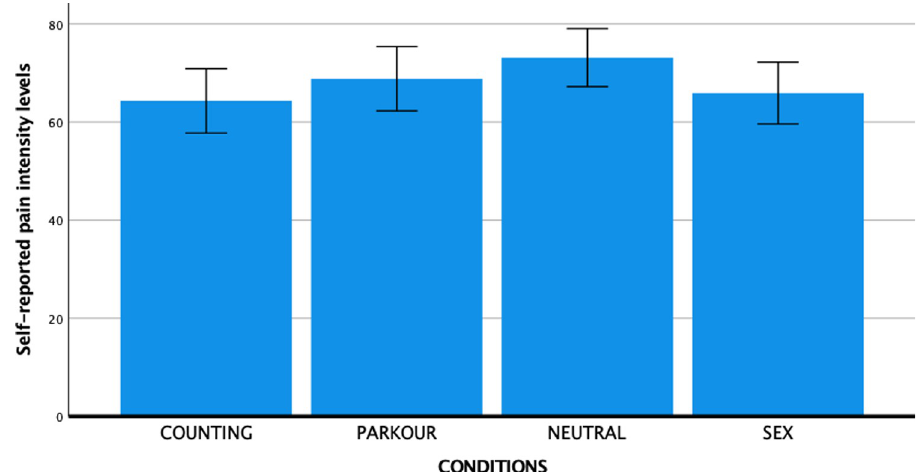
Fig 5. Graphical illustration of subjective pain ratings per condition with error bars representing 95% confidence